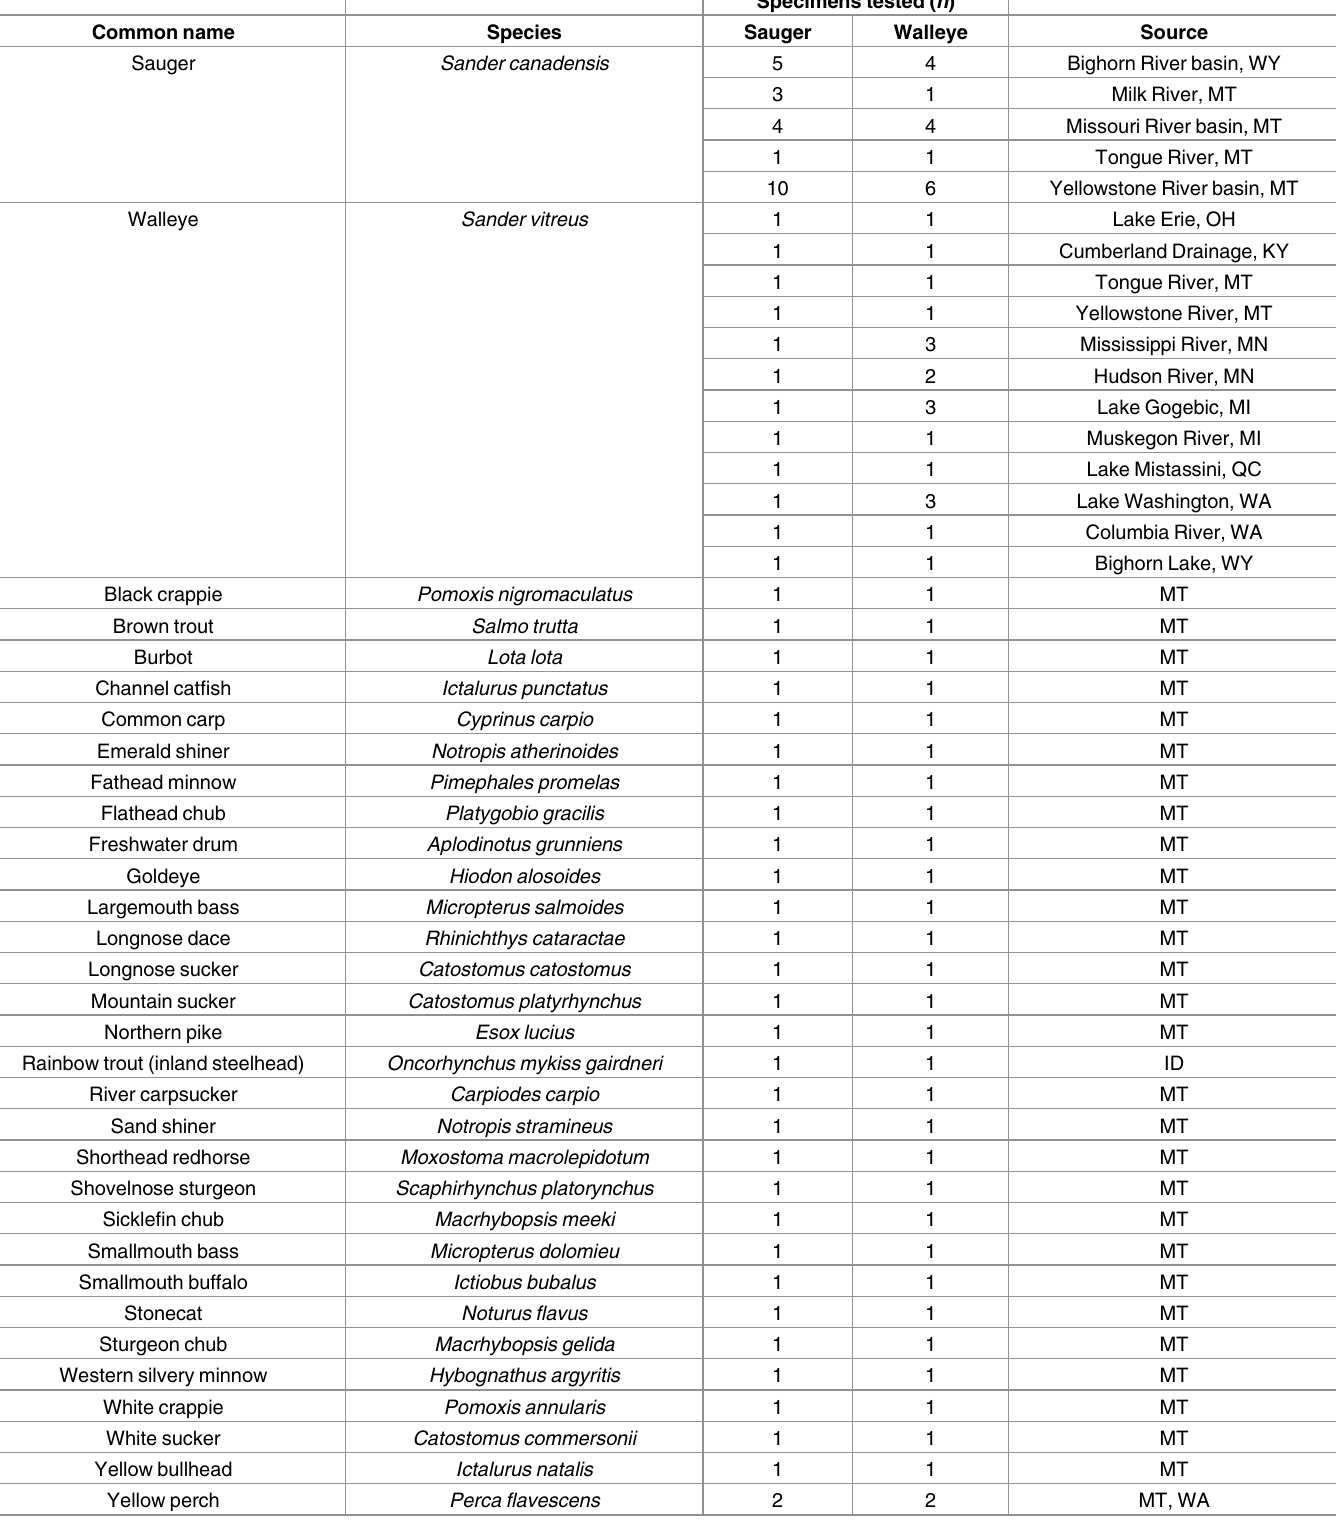
Table 3. Species used for in vitro testing of the primers and probe. Source refers to the waterbody for sauger and walleyespecimens. For all other spec- imens, source is listed by